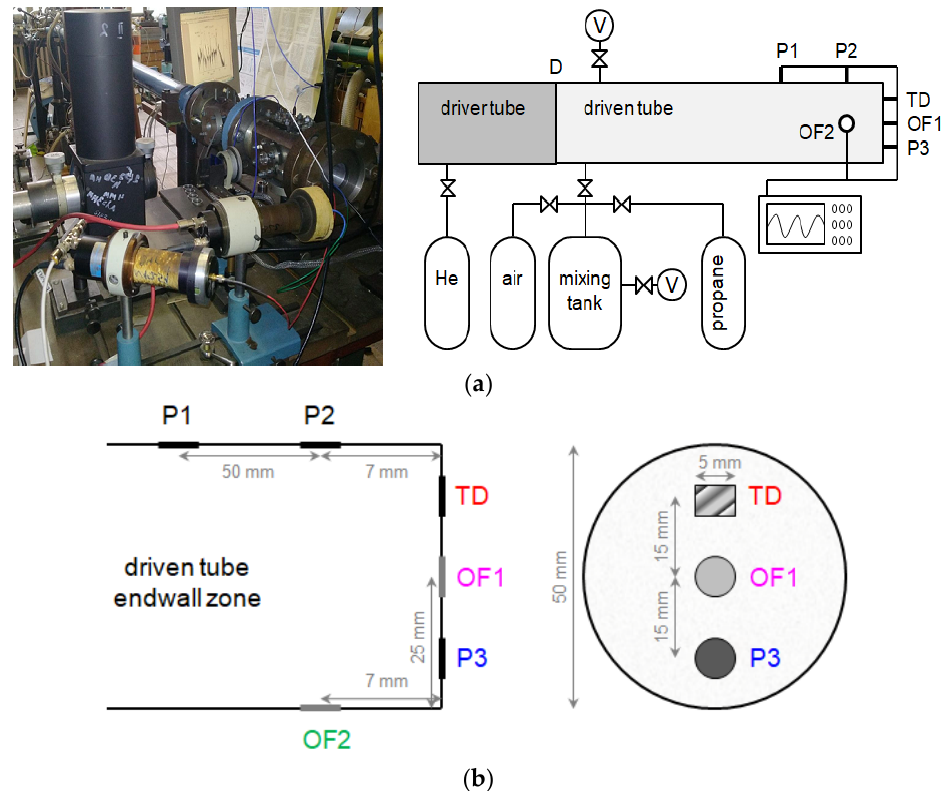
Figure 1. Photo with schematic of the shock tube ( a ) and endwall zone scheme ( b ): P1–P3 are pressure sensors; OF1 and OF2 are optical fibers; TD is thermoelectric